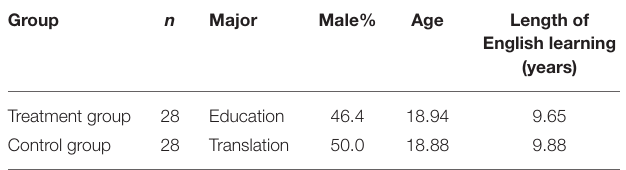
TABLE 1 | Participant’s demographic